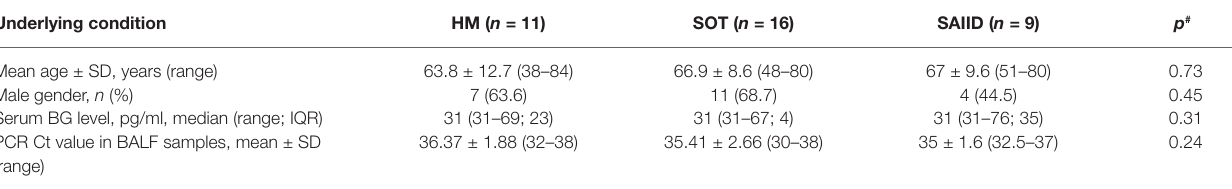
TABLE 5 | Statistical analyses of variables in patients colonized by Pneumocystis , according to the underlying condition. Underlying